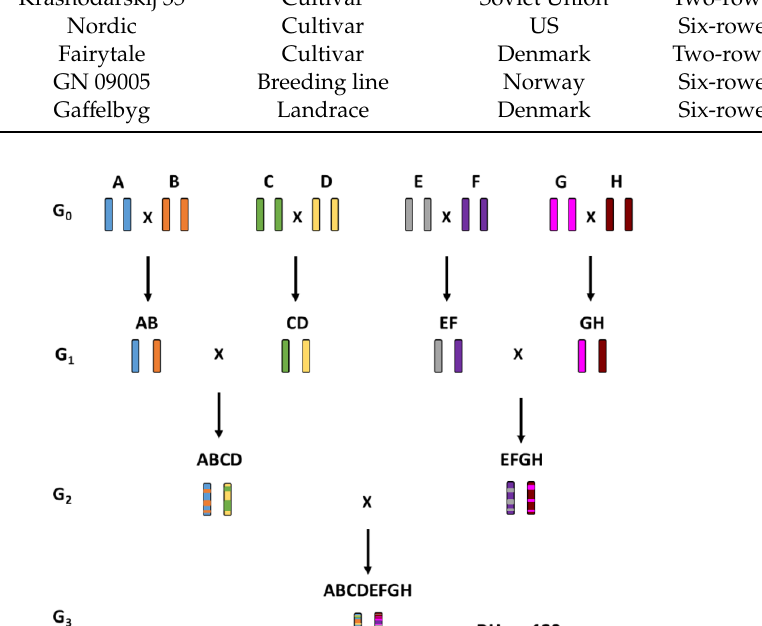
Table 2. Crossing scheme for the four barley MAGIC populations.